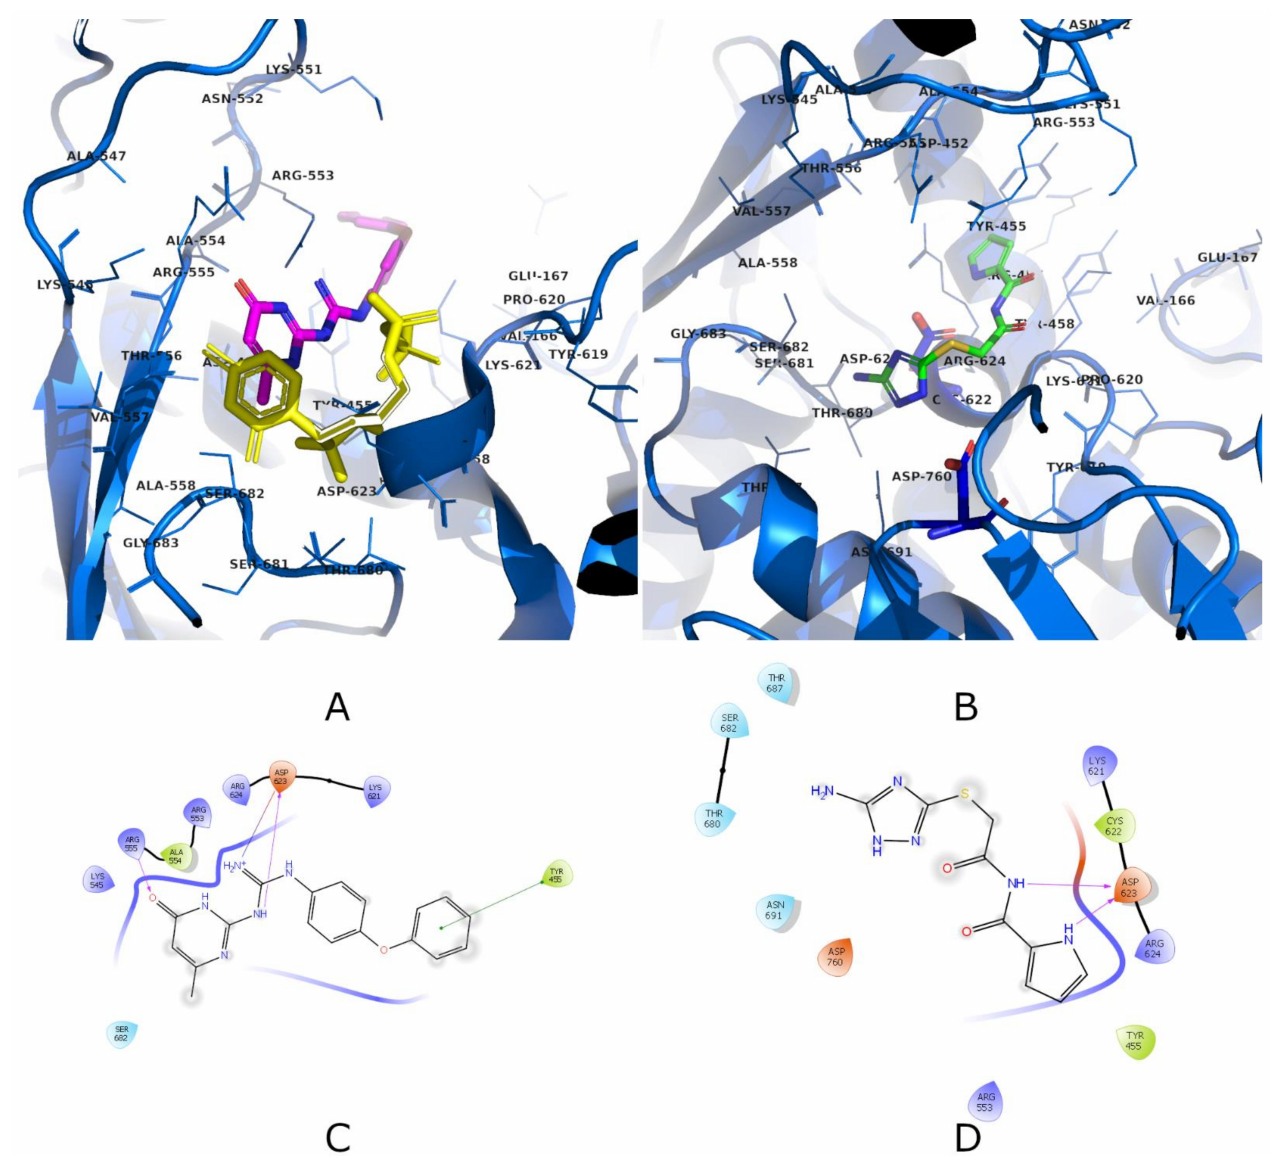
Figure 6. Panel ( A ): The predicted binding mode of Compound 1 (magenta stick model) to the SARS-CoV-2 RdRp (sofosbuvir reference ligand colored in yellow); Panel ( B ): The predicted binding mode of Compound 4 (green stick model) in the vicinity of the key Asp623 and Asp760 residues; Panel ( C ): Compound 1 in the SARS-CoV-2 RdRp active site in a 2D projection; Panel ( D ): Compound 4 in the SARS-CoV-2 RdRp active site in a 2D